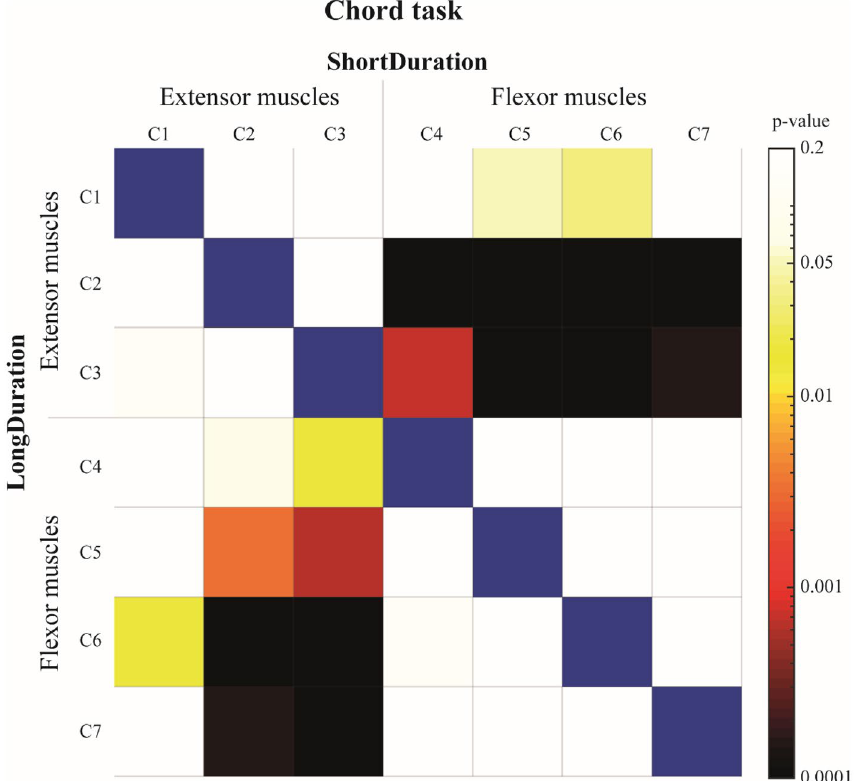
Figure 6. Colormap representation of p values of the Tukey post-hoc analysis for the columns’ comparison of the Chord task. Results of the ShortDuration group are represented above the blue diagonal while results of the LongDuration group are represented below the blue diagonal (α = 0.05). For example, the variation of EMG median frequency (I 5 –I 0 ) of c1 for the ShortDuration group (first row, first column) is not significantly different from c2 (first row, second column), but is significantly different from c5 (first row, fifth column). Similarly, the variation of EMG median frequency (I 5 –I 0 ) of c1 for the LongDuration group (first column, first row) is not significantly different from c2 (first column, second row), but is significantly different from c6 (first column, sixth